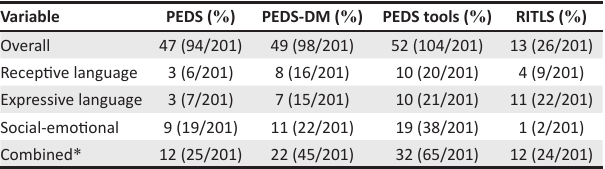
RITLS, Rossetti Infant-Toddler Language Scale; PEDS, Parents’ Evaluation of Developmental Status; PEDS-DM, PEDS-Developmental Milestones. * Receptive and expressive language and social-emotional skills.